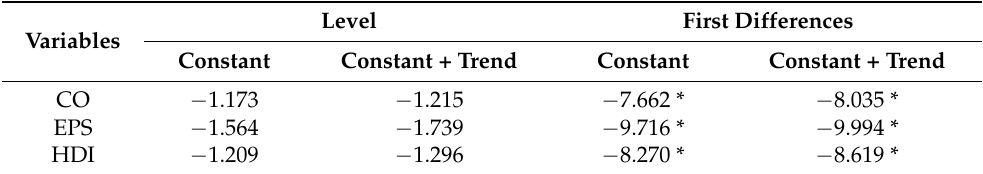
Table 5. Pesaran (2007) CIPS unit root test.